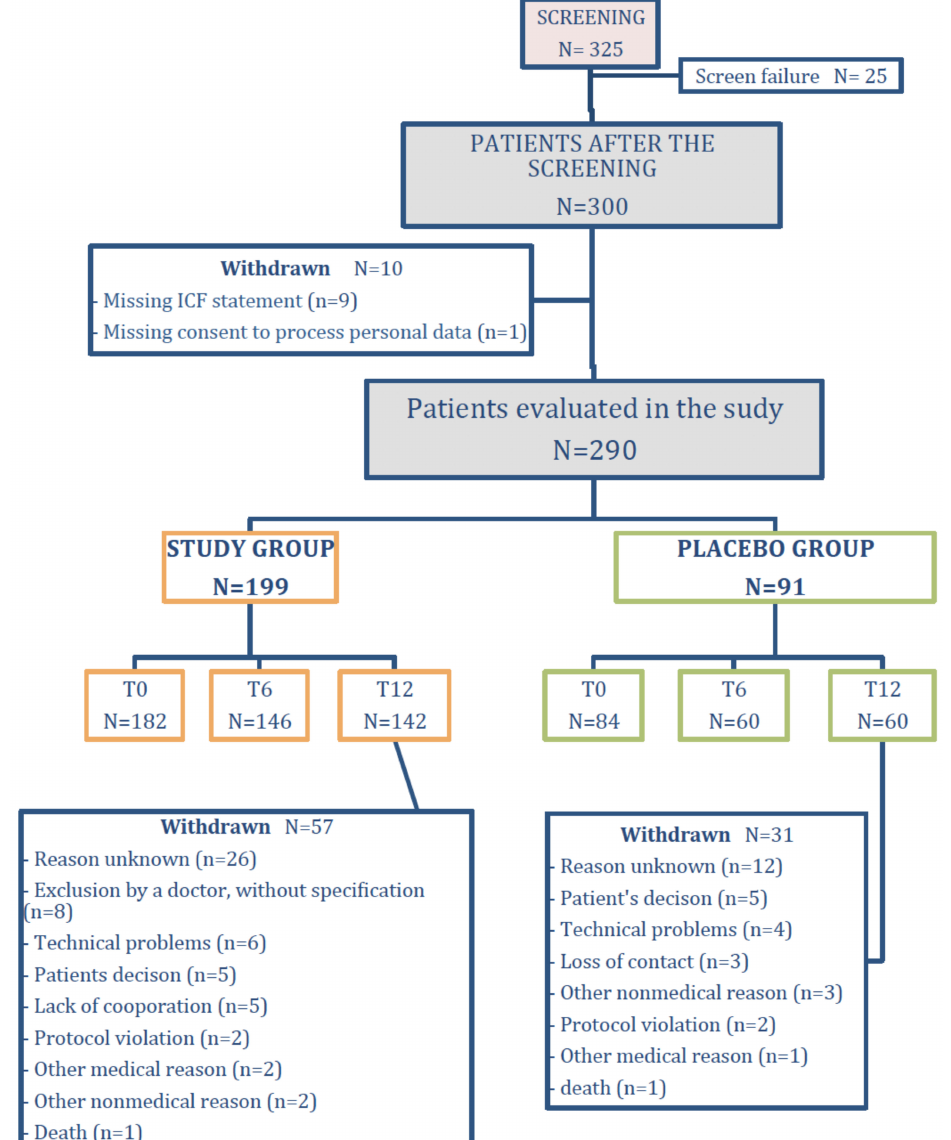
Figure 1. Participant flow throughout the study. Changes in the analyzed population during 12 months of the study are illustrated, based on the number of patients who underwent visits to the doctor’s o ffi ce at baseline (T0), after 6 months (T6), and at the end of the study (after 12 months,